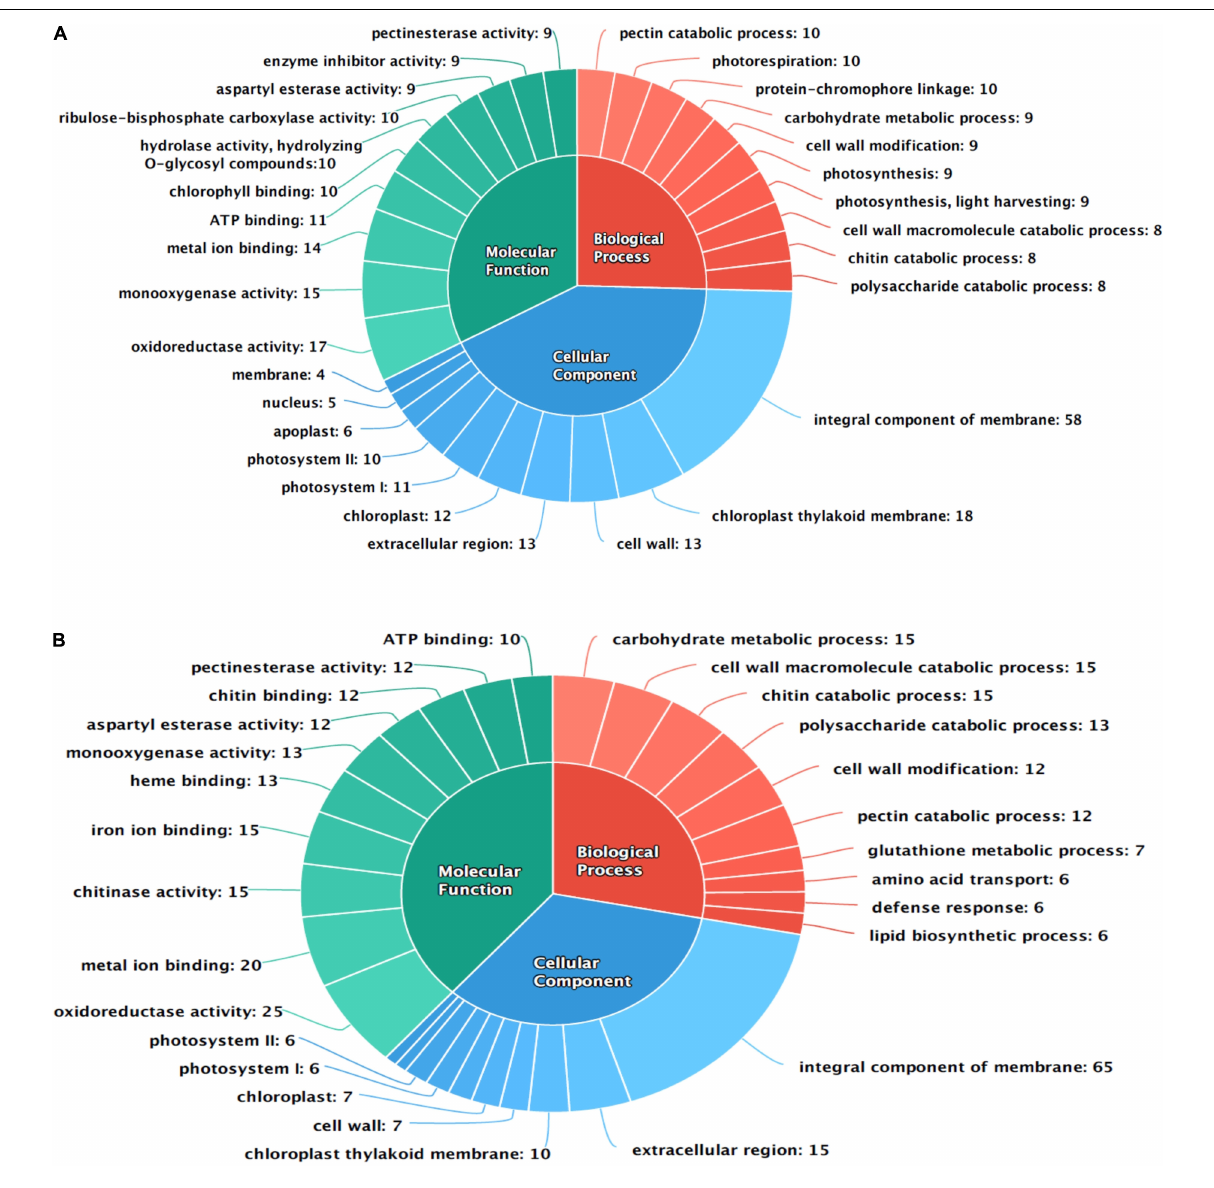
FIGURE 2 | Functional annotation of differentially expressed transcripts in response to PB in onion using gene ontology (GO); (A) AK and (B) AFR.